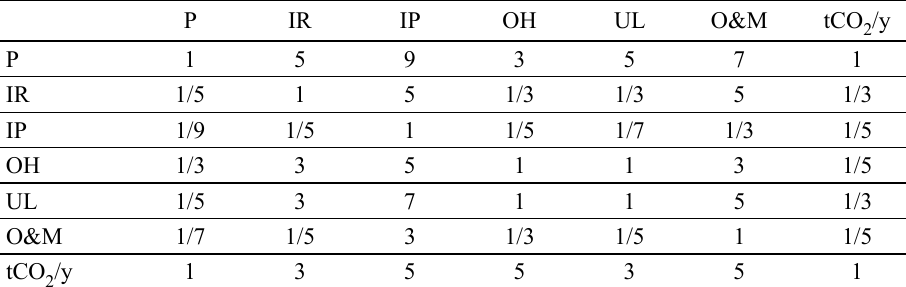
Table 4. Pairwise comparison